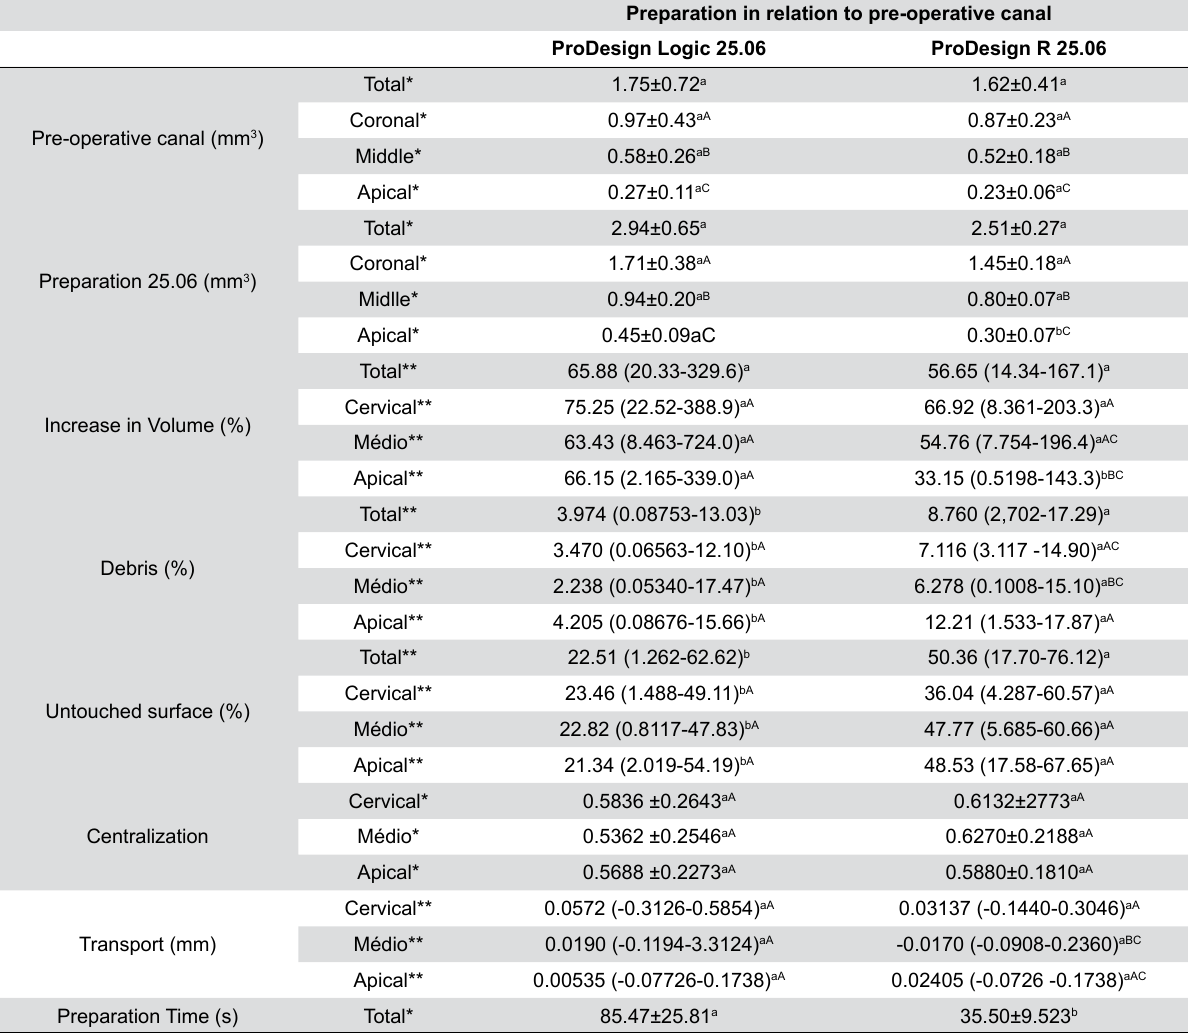
Table 1- Root canal volume, increase in volume (%), debris (%), untouched root canal surface (%), centralization, transport and preparation time after preparation with ProDesign Logic 25.06 and Processing R 25.06